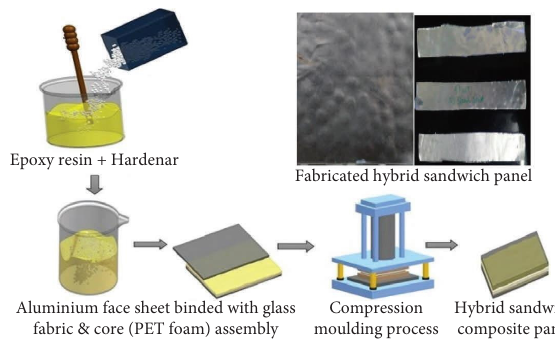
Figure 1: Preparation process for the hybrid sandwich